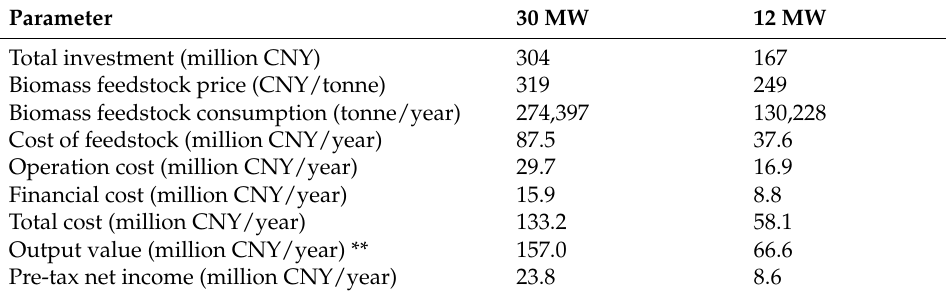
Table 3. Annual revenue and cost in 2017